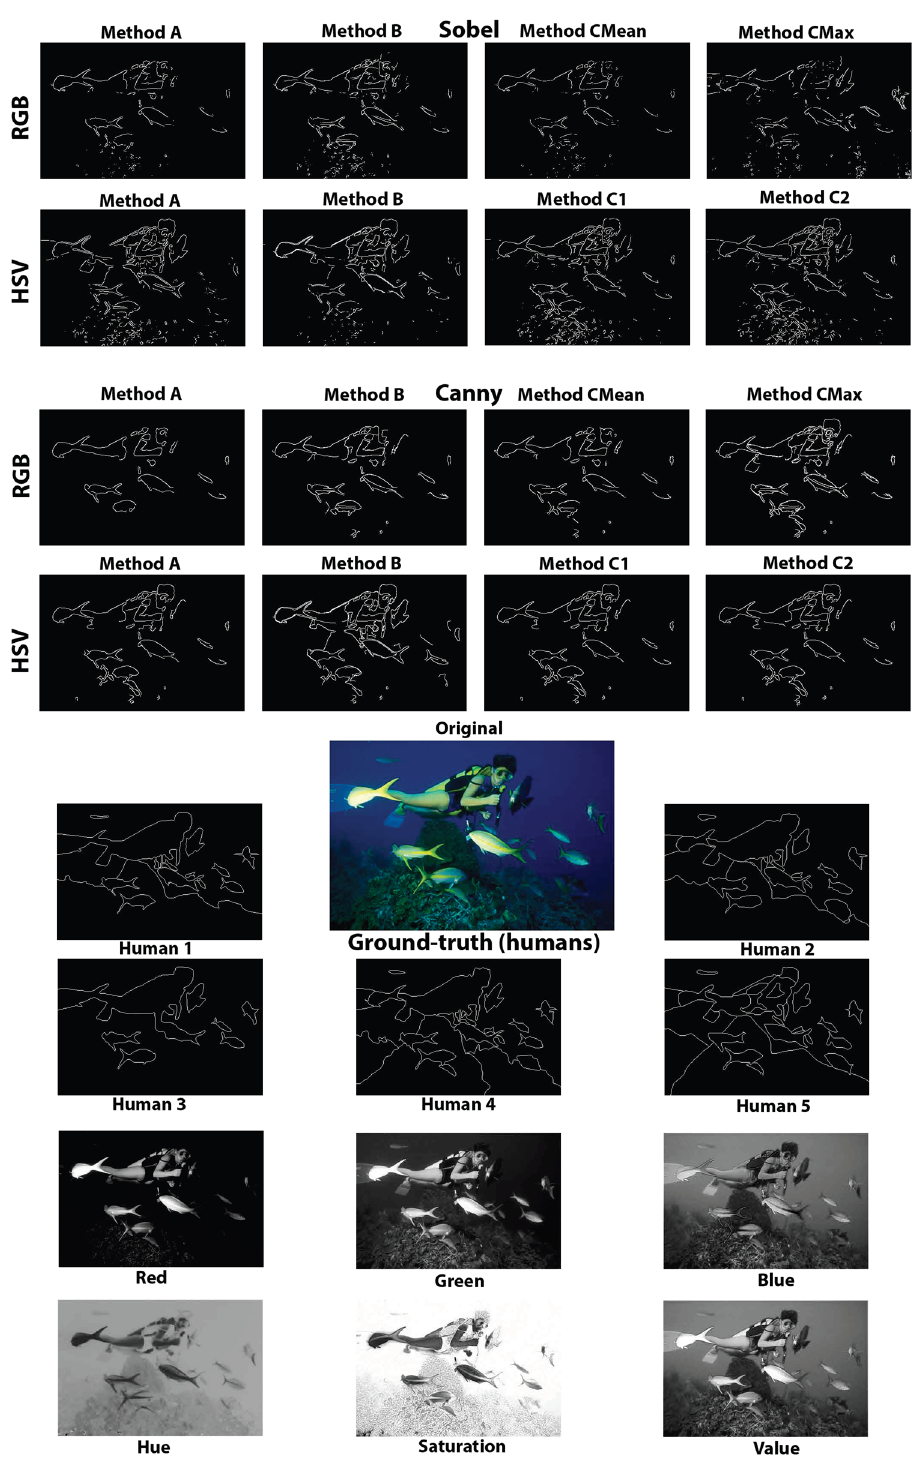
Fig. 4 Best outputs for all meth- ods for an example’s